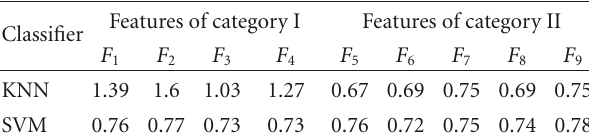
Table 4: The selection metric of the two categories features.